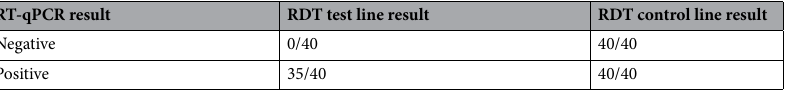
Table 3. Concordance of the SARS-COV-2 antigen RDT assay and the ExoDx COVID-19 RT-qPCR assay. SARS-CoV-2 antigen RDT results achieved 87.5% sensitivity and 100% specificity in a clinical cohort of 40 negative samples and 40 positives that were confirmed by RT-qPCR.